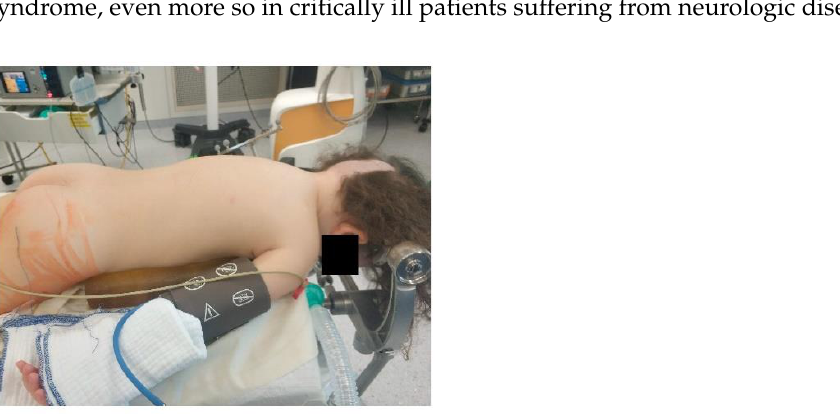
Figure 2. Prone positioning with lateral soft rolls to elevate and support lateral chest wall, tubus fixation.